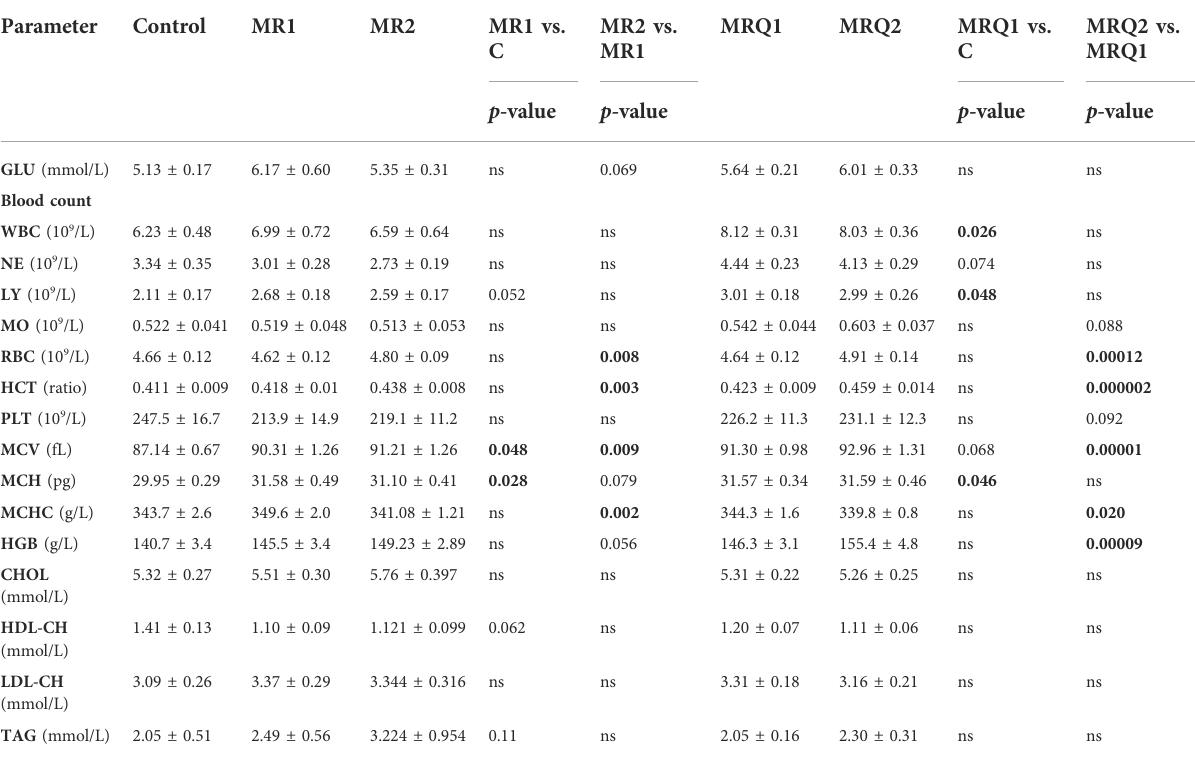
TABLE 3 Blood count and biochemical parameters in control subjects and patients with post C-19, the effect of rehabilitation program without/with ubiquinol supplementation.